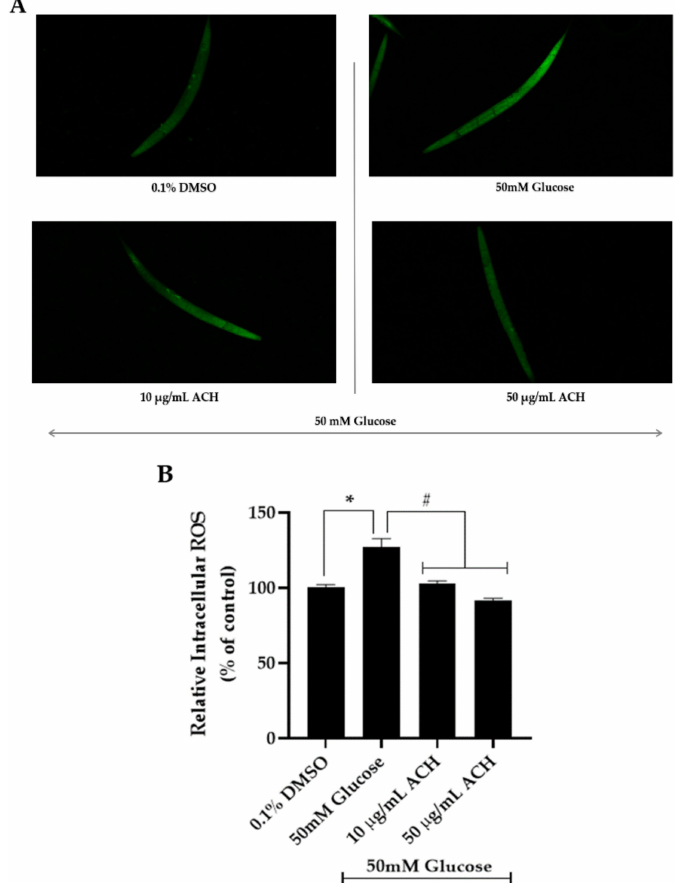
Figure 5. The protective effect of ACH extracts on high glucose-induced oxidative stress in C. elegans . Intracellular ROS accumulation was performed using H2DCFDA assay and imaged by a confocal microscope ( A ). Relative intracellular ROS accumulation level is shown in ( B ). Data are presented as the means ± SEM, * p < 0.05 vs. control; # p < 0.05 vs. high glucose-fed worms.